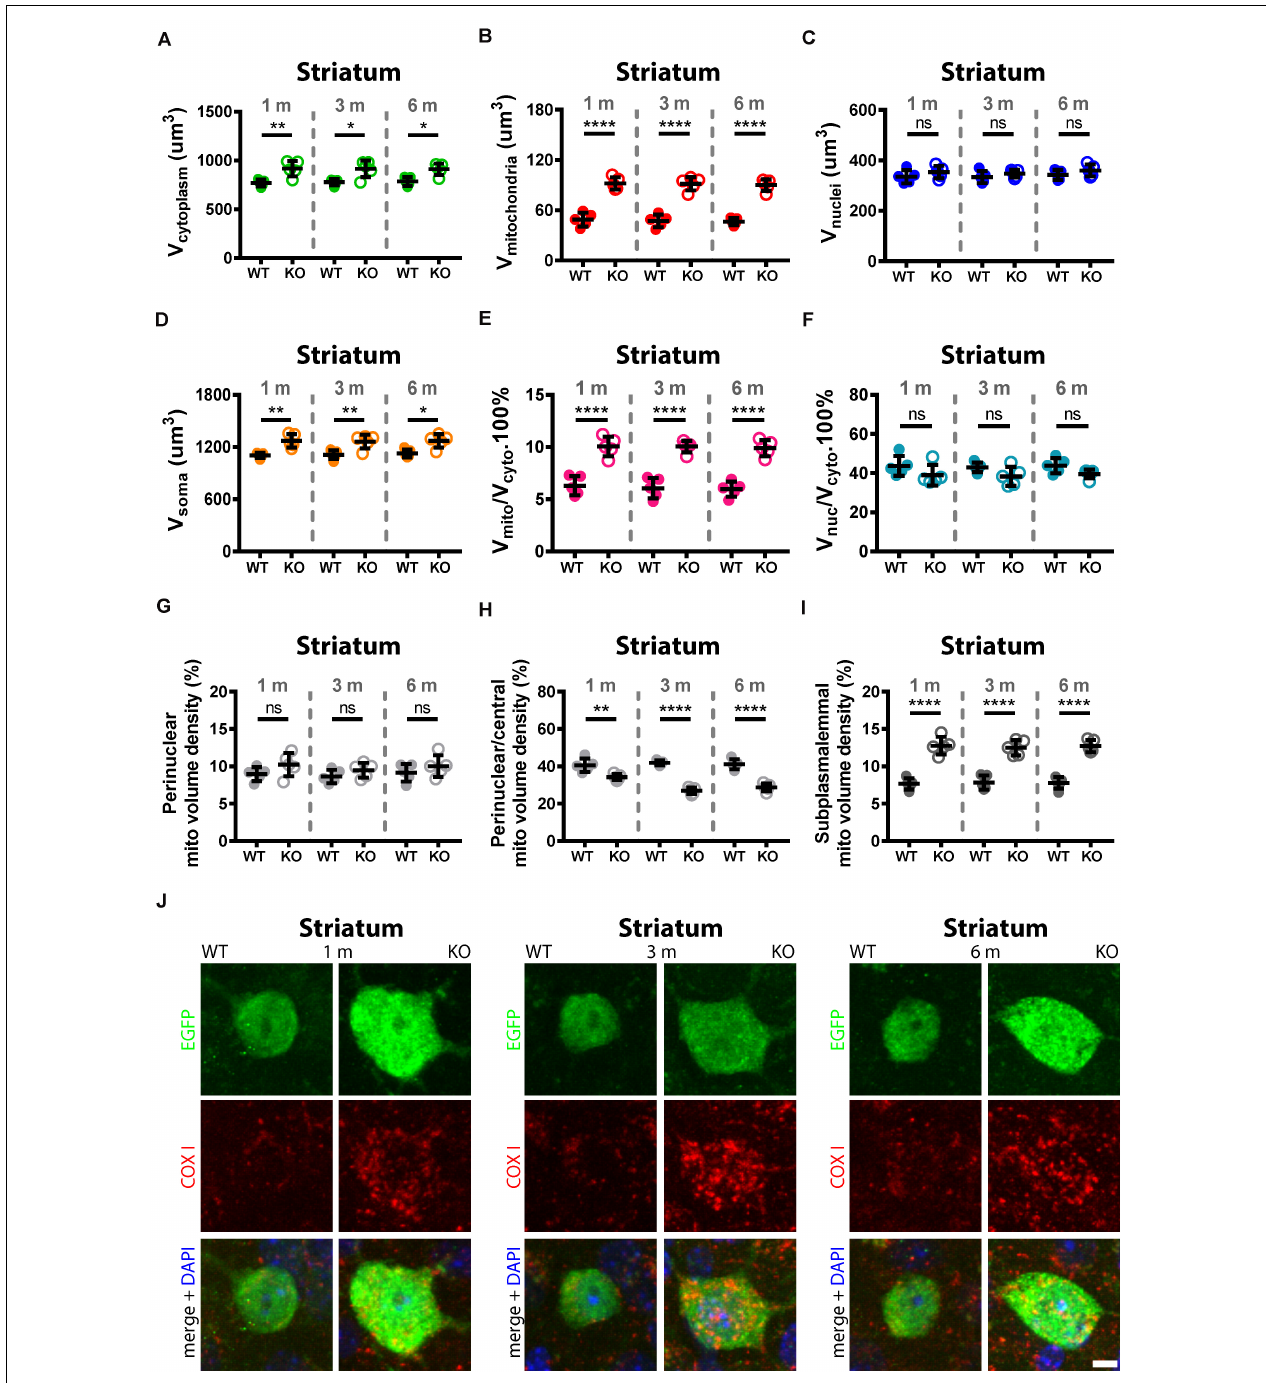
FIGURE 6 | Quantitative morphological analyses of TRN Pvalb neurons. A comparison was carried out in 1, 3, and 6-months old WT and KO mice. Analyzed parameters included volume of cytoplasm (A) , volume of mitochondria (B), volume of nuclei (C), and volume of soma (D) in a given Pvalb neuron. Additional parameters were calculated, such as ratio V mitochondria /V cytoplasm (E) and V nucleus /V cytoplasm (F) . Quantitative analyses of the relative distribution of mitochondria within the cytoplasmic compartment in striatal Pvalb neurons (G–I) . Somata and nuclei of selected Pvalb neurons were identified based on EGFP and DAPI staining, respectively and the distribution of mitochondria from the center of the cell (border of nuclei) to the plasma membrane was partitioned into a set of 4 specified zones: 1 being the innermost (perinuclear) and 4 the outermost (subplasmalemmal). Quantitative analyses are shown for zone 1 (perinuclear; G ), zone 2 (perinuclear/central H ) and zone 4 (subplasmalemmal; I ) mitochondrial volume density. Note the mitochondria shift from the perinuclear region to the periphery of the cells in KO mice. Representative confocal images (J) of EGFP-stained Pvalb neurons (green; cytoplasm), COX I (red; mitochondria) and DAPI (blue; nuclei) at all observed time points (1, 3, and 6 months) are shown for WT and KO mice. Scale bar: 5 µ m. Each dot in the graphs represents the average obtained in 1 animal (5 mice per genotype) and 10–15 cells per animal resulting in > 50 cells per striatal region and genotype. ns: not significant; * p < 0.05; ** p < 0.01; *** p < 0.001; **** p < 0.0001. Values are reported in Table 2